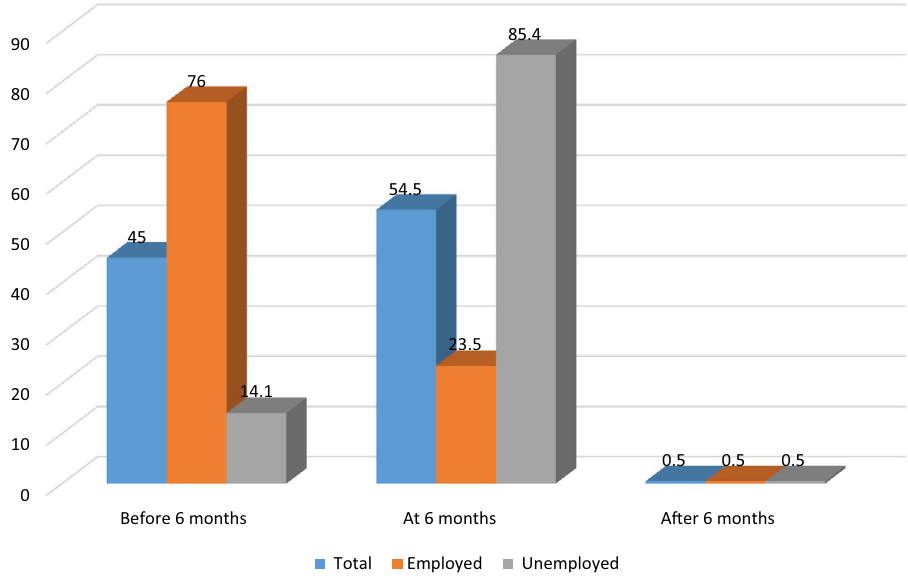
Figure 1. Percentage of cessation of EBF by the duration of time among employed and unemployed mothers in Debre tabor town, South Gondar Zone, North West Ethiopia, 2019.